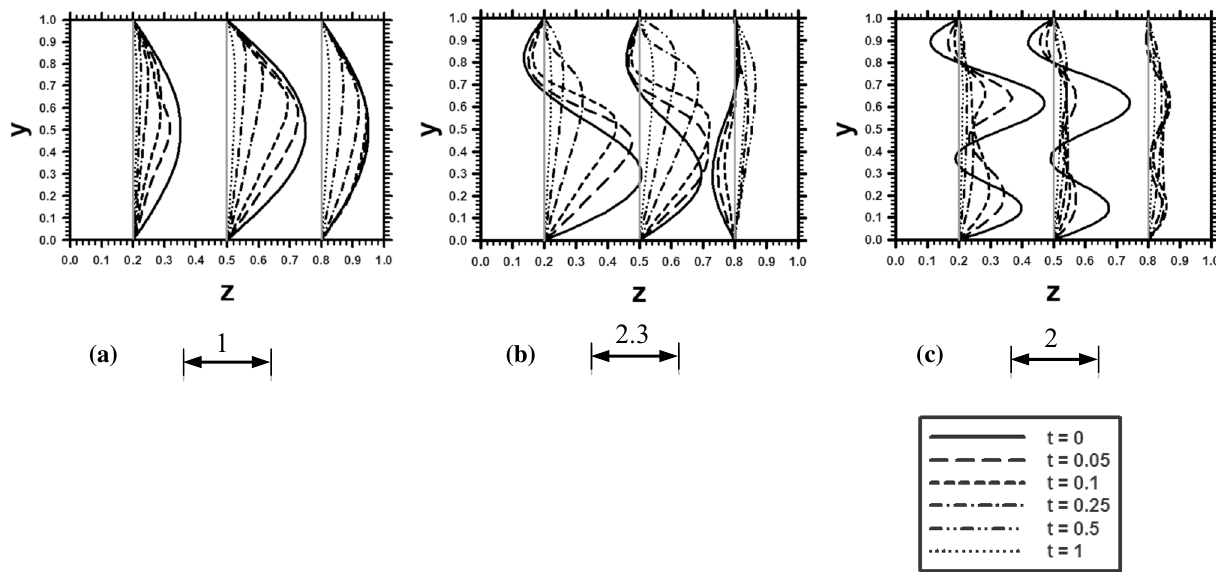
Fig. 3 A sample of distribution of the velocity of the a longitudinal ( u ), b depth ( v ) and c transverse ( w ) along the depth and for passing plate 𝜐 through the middle of the length ( =